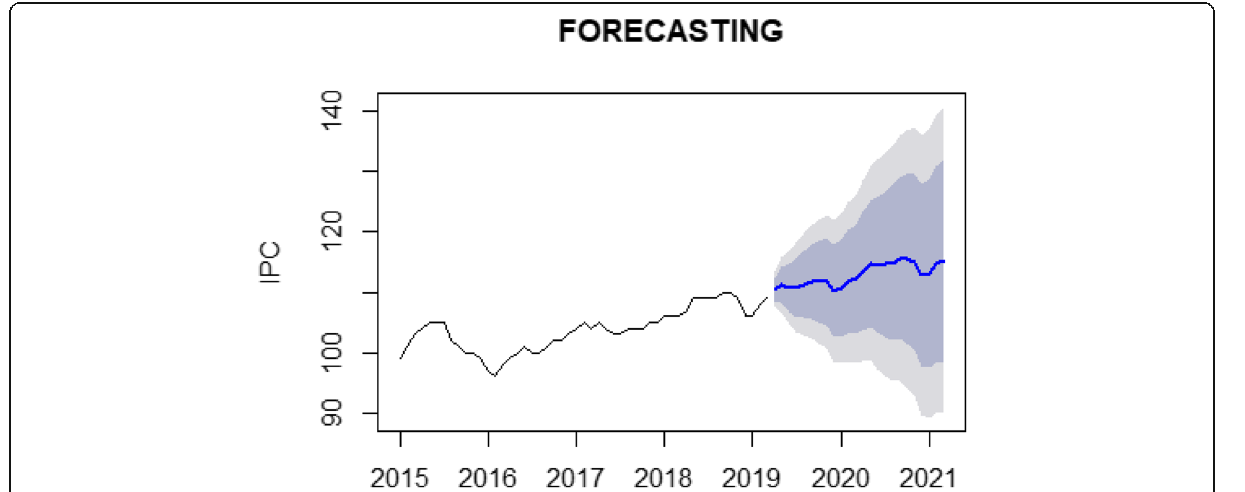
Fig. 3 The consumer price index of the transport sector between 2015 and 2019